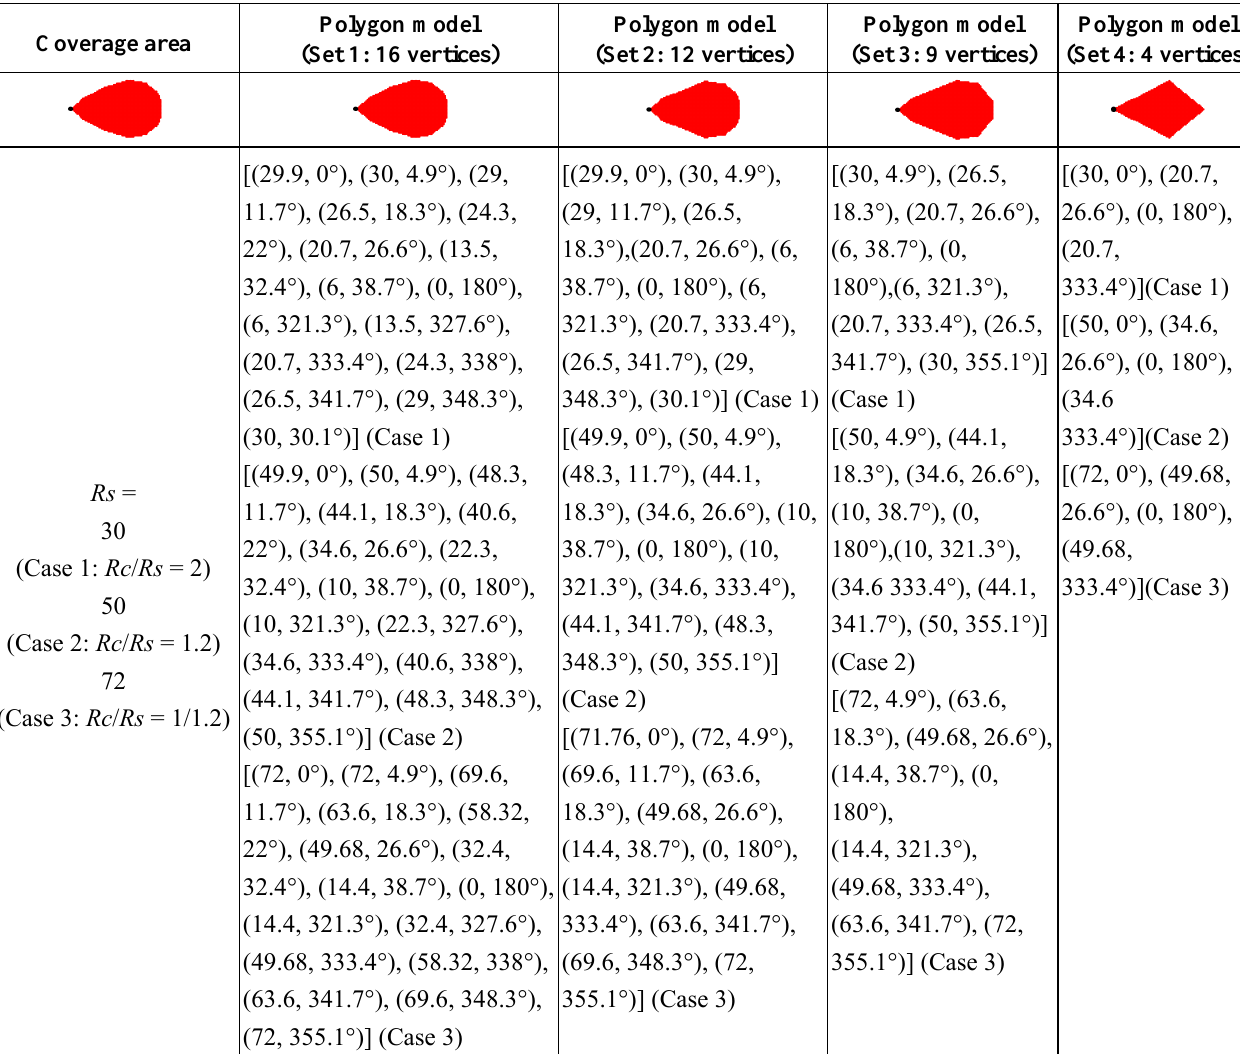
Table 8. The configuration of Type 2 sensor node in Simulation